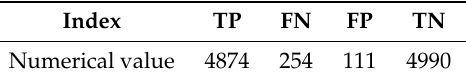
Table 22. Forecast indices value.